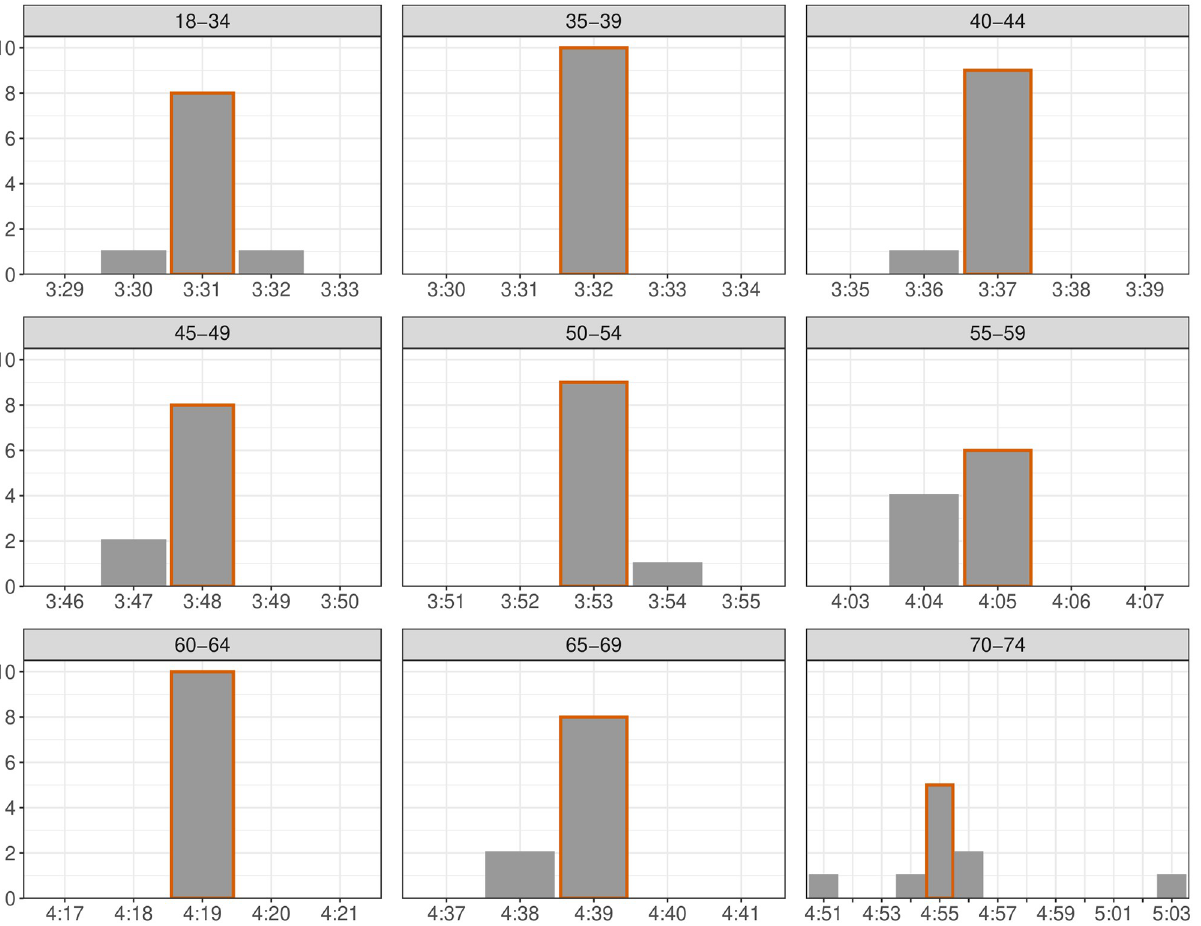
Fig 3. Optimized difference in proportions QTs found when excluding one of the ten marathons at a time. The Optimized QTs across all marathons is highlighted in red.